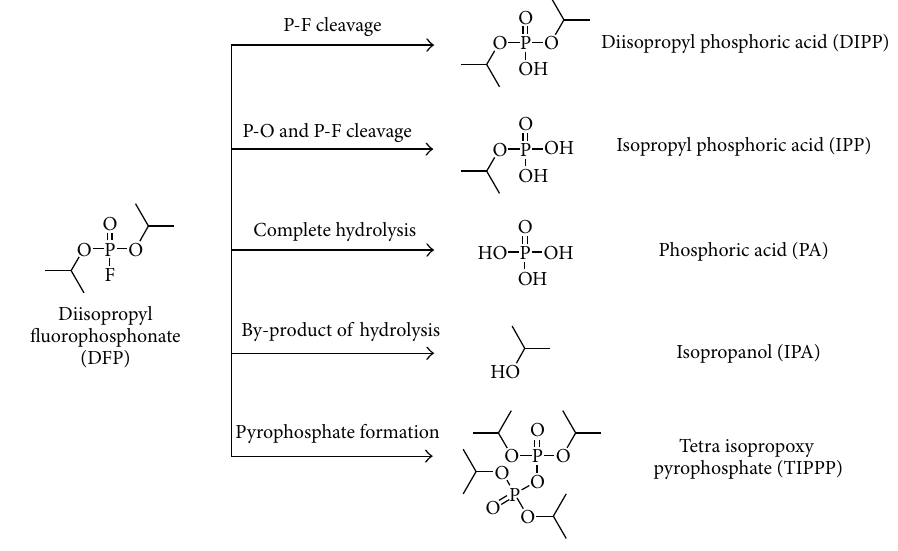
S 3: Degradation products of DFP.